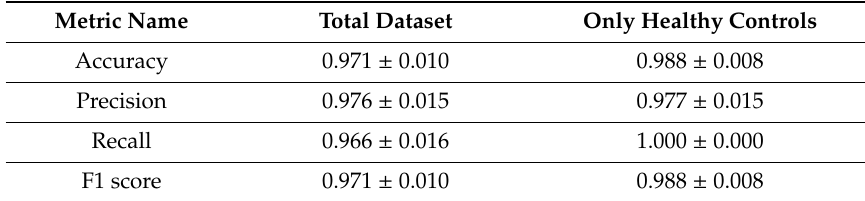
Figure S1: The boxplot of the phylum abundance for the projects used in the study; Figure S2A–D: The boxplot of the taxa significant in the MW test; Figure S3: ROC-curves for family and genus random forest models